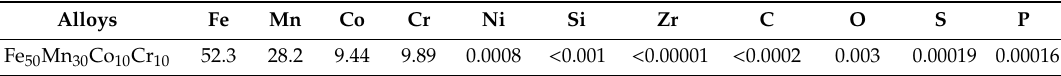
Table 1. Detailed chemical compositions (at.%) of the Fe 50 Mn 30 Co 10 Cr 10 powder.